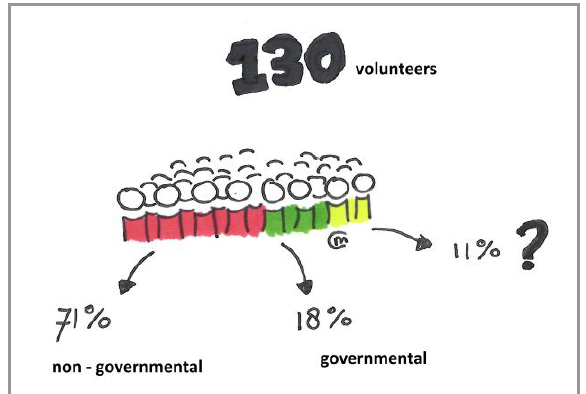
Figure 5. Different groups of